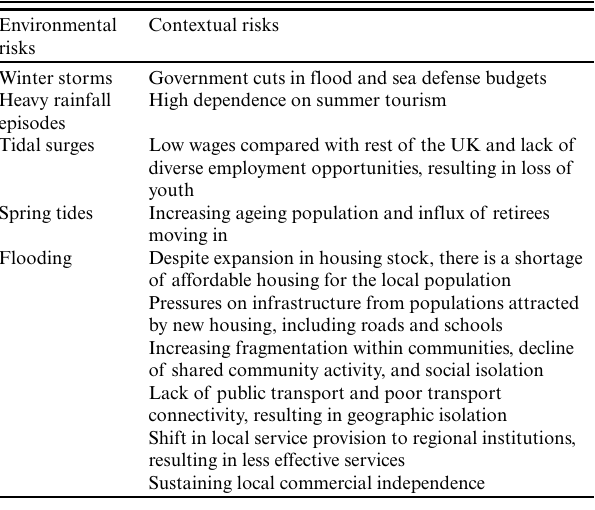
Table 2. Key risks for communities in Boscastle and Wadebridge (Cornwall Strategic Partnership 2008, Cornwall Council